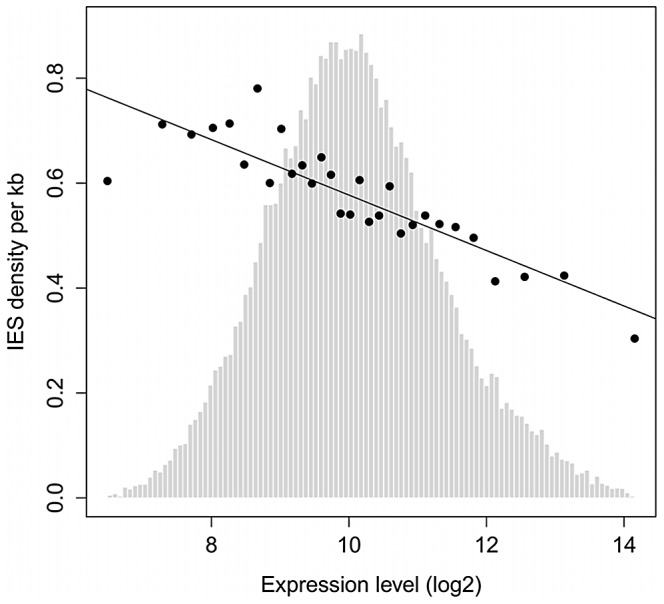
IES density is inversely proportional to gene expression level.Genes were binned according to their median expression level across 58 microarrays representing different cellular and growth conditions as described in [38], [39]. The expression levels were divided into 30 bins as in [38]. The black points show the average IES density (per Kb) of genes in each bin. Linear regression was used to fit the points. Light gray bars show the distribution of genes according to their expression level (before binning).